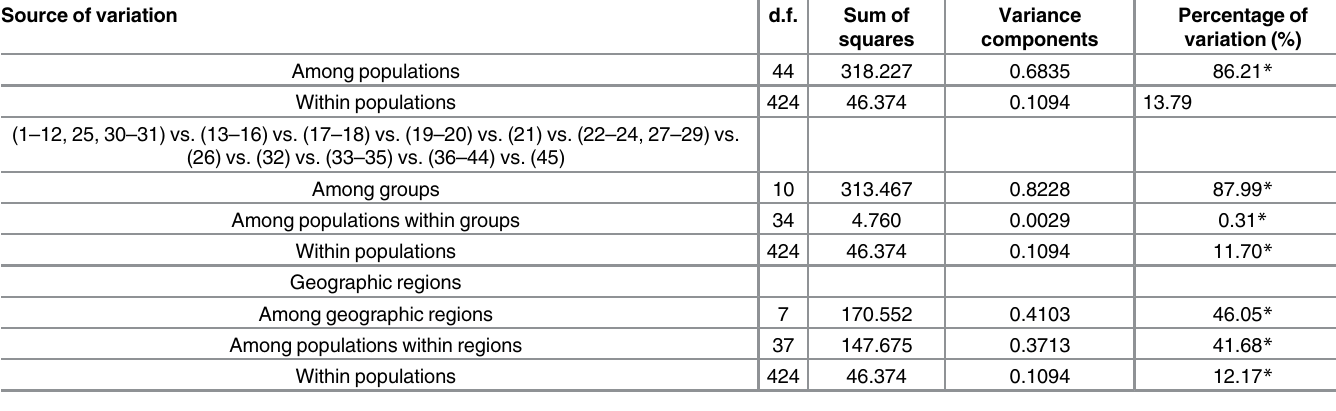
Table 2. Results of analysis of molecular variance for Ephedra przewalskii based on chloroplast DNA sequence data. Source of